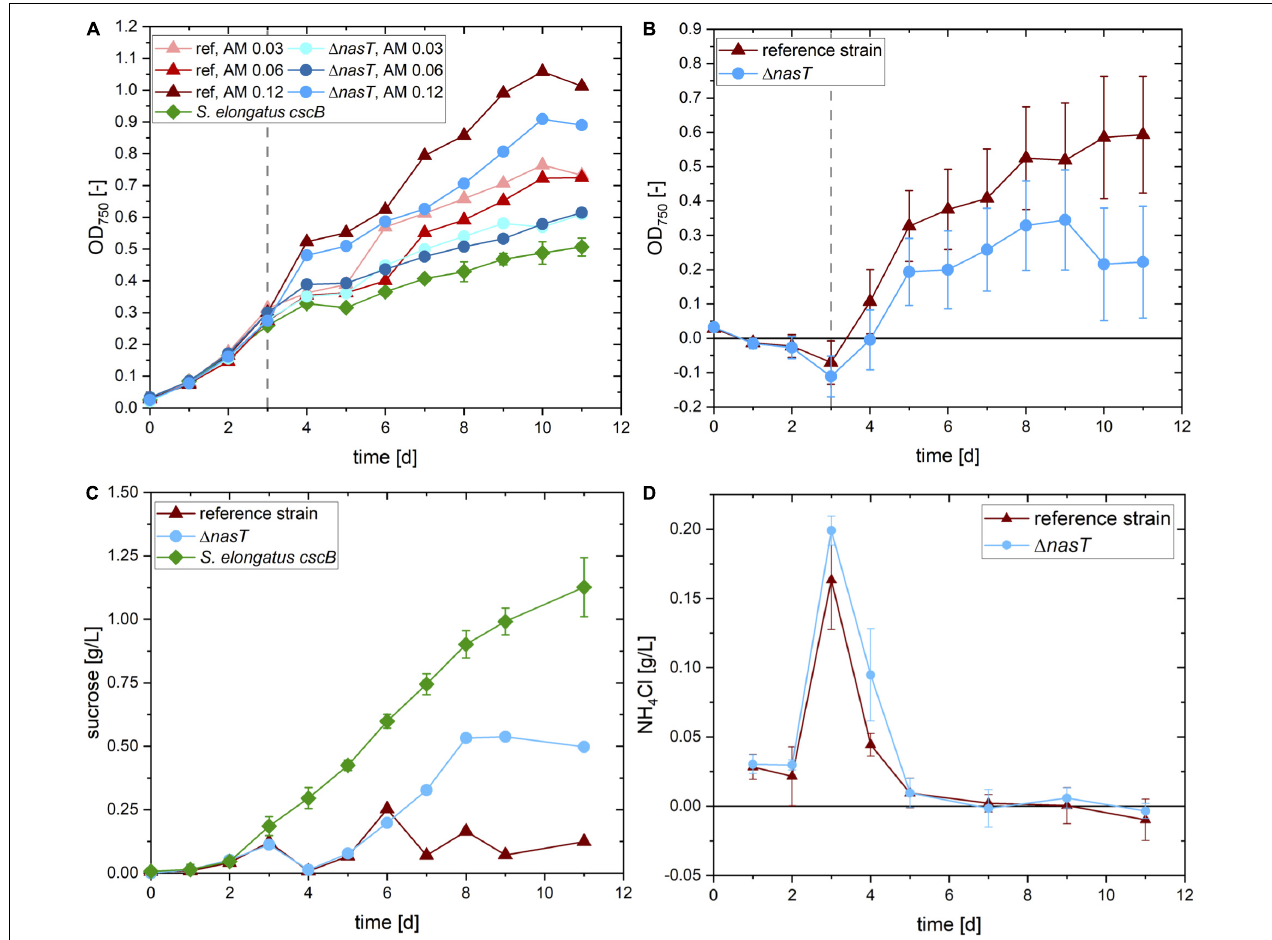
FIGURE 3 | Co-cultivation of S. elongatus cscB and P. putida cscRABY (cid:49) nasT . (A) Total OD at 750 nm of the cultures with different ammonium concentrations. S. elongatus cscB (green diamonds) was grown in mono-culture as control. Co-cultivations were done with P. putida cscRABY (ref; triangles) or with P. putida cscRABY (cid:49) nasT ( (cid:49) nasT ; circles), AM 0.03: 0.03 g/L NH 4 Cl; AM 0.06: 0.06 g/L NH 4 Cl; AM 0.12: 0.12 g/L NH 4 Cl. (B) Estimated optical density of the P. putida fraction of the co-cultivations with 0.12 g/L ammonium of P. putida cscRABY (red triangles) and P. putida cscRABY (cid:49) nasT (blue circles). (C) Sucrose present in the control cultivation with S. elongatus cscB alone (green squares), or the co-cultivations with 0.12 g/L ammonium with P. putida cscRABY reference strain (red triangles), or P. putida cscRABY (cid:49) nasT (blue circles). (D) Development of the NH 4 Cl concentrations in the co-cultivations with 0.12 g/L ammonium with P. putida cscRABY reference strain (red triangles) or P. putida cscRABY (cid:49) nasT (blue